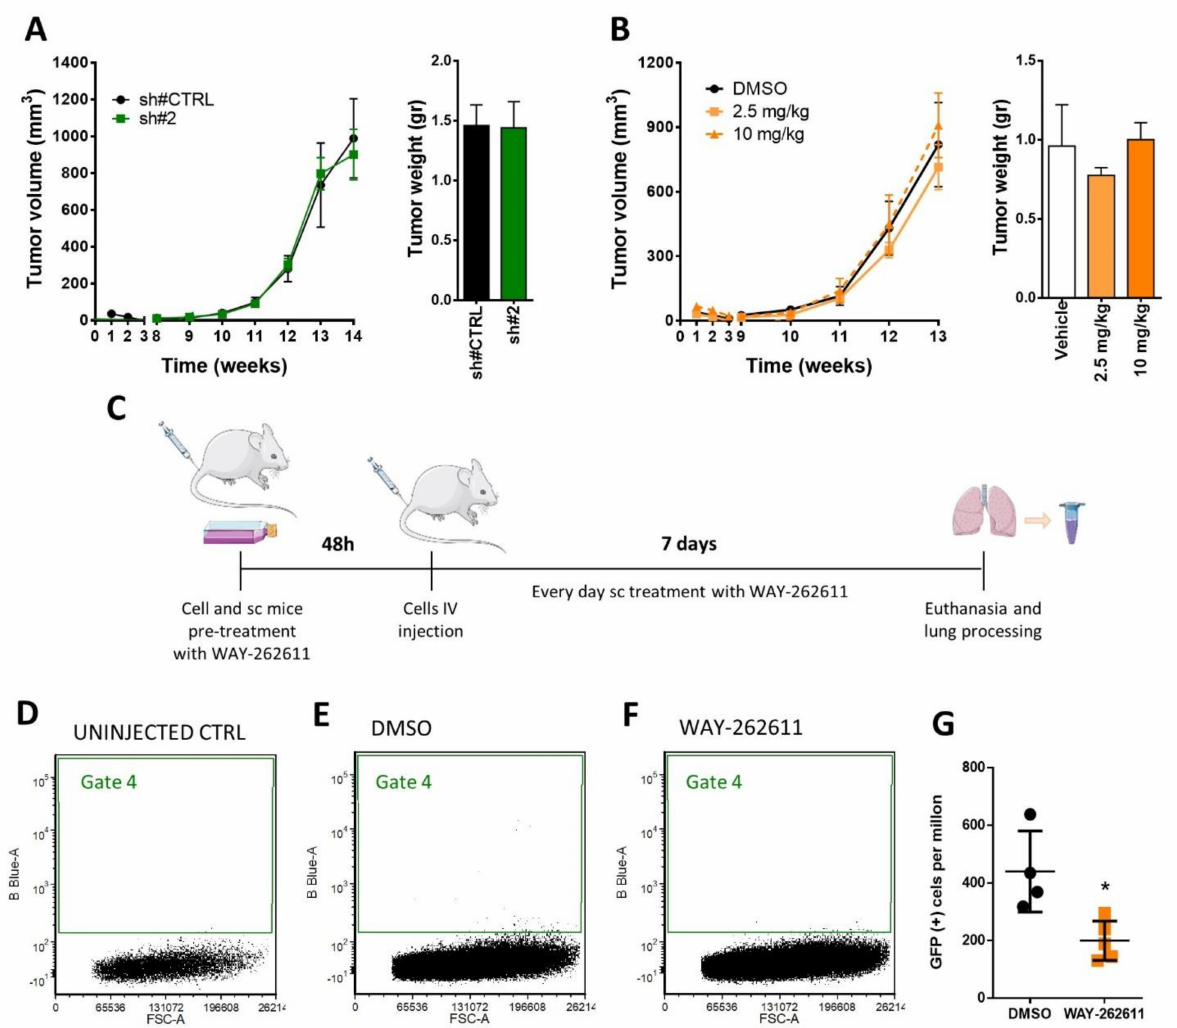
Figure 4. Analysis of DKK-1 inhibition by genetic knockdown and WAY-2626211 in mouse models. Orthotopic models were established by intramuscular injection of RD cells. ( A ) Tumor growth kinetics ( left panel) and tumor weight at the end of the experiment (right panel) were evaluated during 14 weeks in mice injected with RD cells carrying the control plasmid or the sh#2. ( B ) Mice injected with RD wt cells were treated with vehicle and two different doses of WAY-262611. The tumor volume was determined weekly during the 13 weeks of treatment ( left panel). At the end of the experiment, the tumor weight was also measured ( right panel). ( C ) Experimental design corresponding to the experimental metastasis model. After 7 days of treatment, whole lungs were extracted and, after tissue homogenization, samples were analyzed by flow cytometry to identify GFP + cells, detected in Gate 4. ( D ) In mice without tumor cell injection, no GFP + cells were detected in the lungs (0.00%). Representative plots derived from ( E ) cytometry analysis of control and ( F ) treated mice are also shown. ( G ) Final data were plotted as GFP + cells/million events in both control and treated mice. * p <